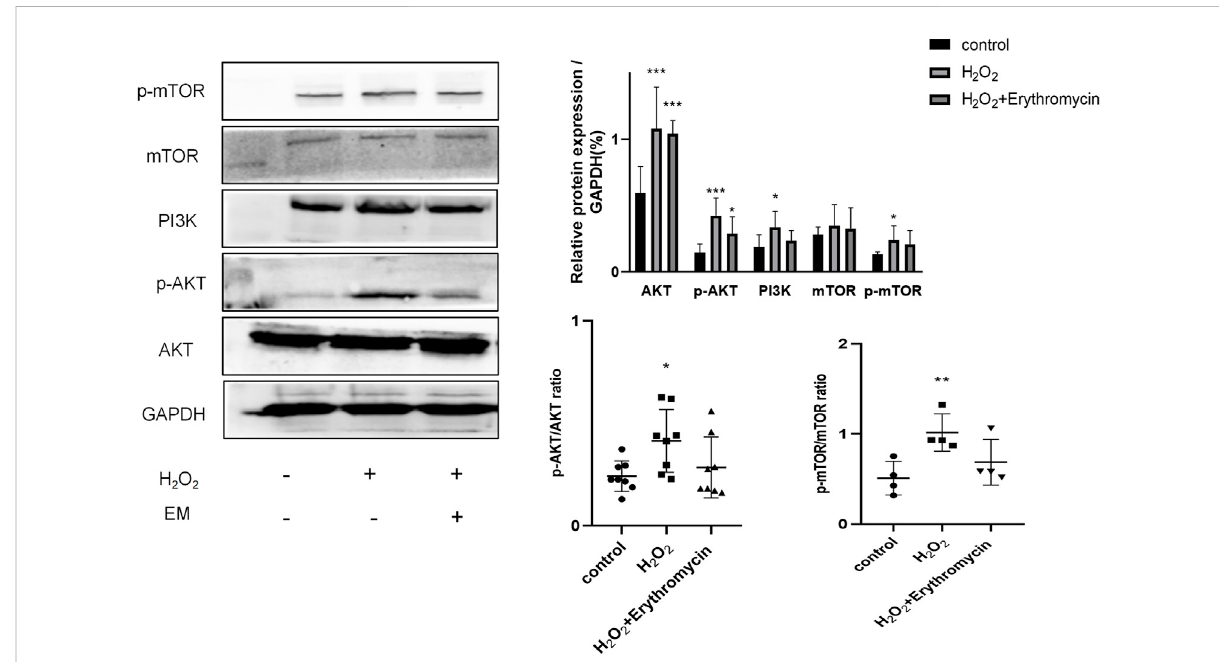
FIGURE 7 Erythromycin inhibited H 2 0 2 -induced BEAS-2B cellular senescence via the PI3K-mTOR signaling pathway. The expression level of proteins of the PI3K-mTOR pathway was assessed using western blot. *** p < 0.0001, ** p < 0.001,* p <